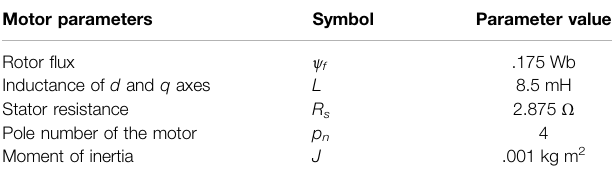
TABLE 1 | Parameters of PMSM.